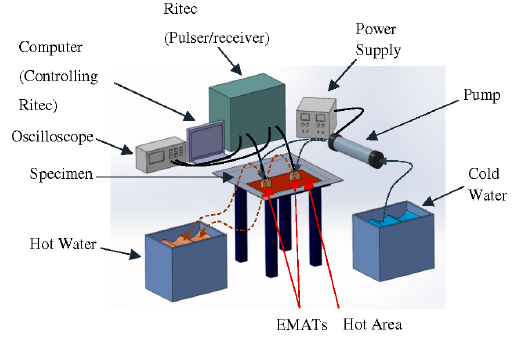
Figure 9. Experimental setup.